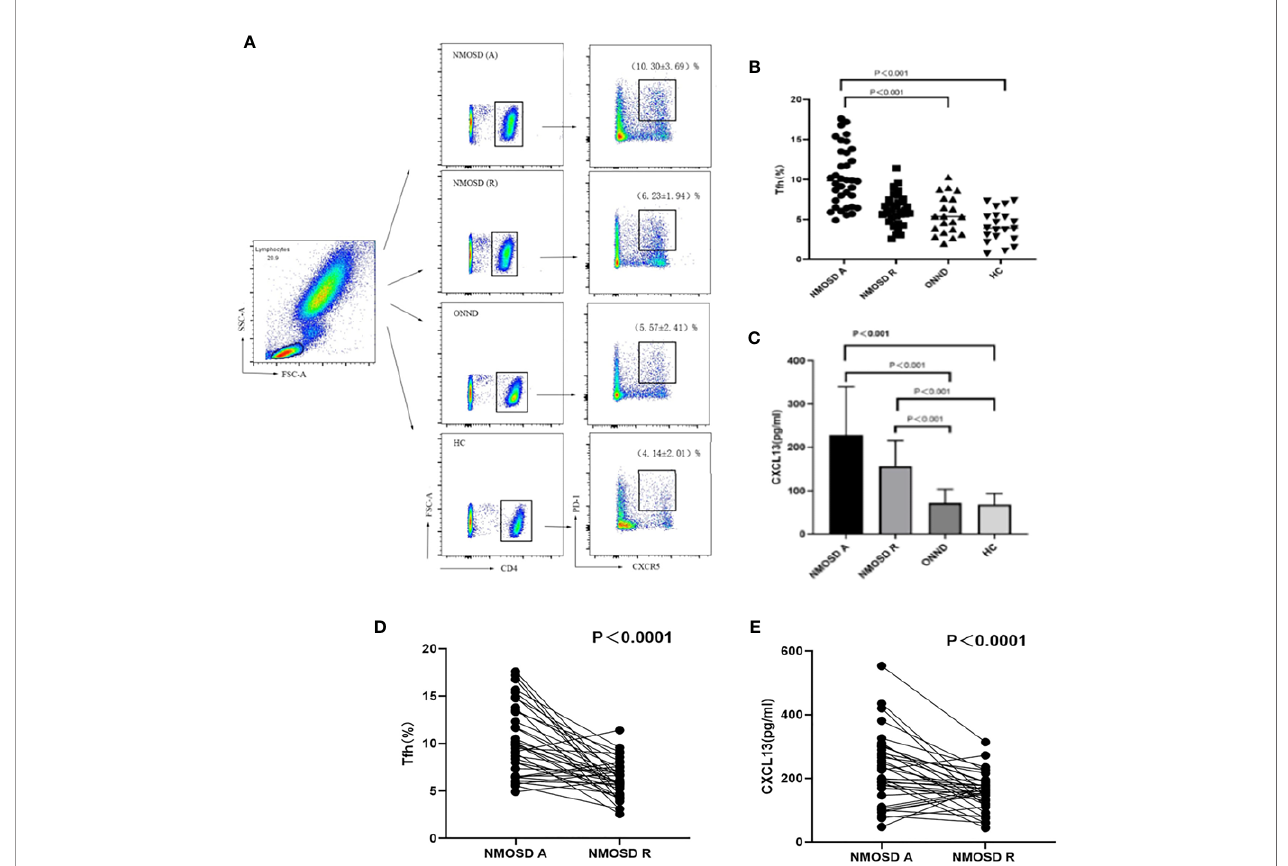
FIGURE 1 | FACS analysis of circulating Tfh cells in individual participants. The cells were gated to obtain results for lymphocytes, CD4+, CXCR5+ and PD-1+cells. (A) Flow cytometric analysis (B, C) Circulating Tfh cell ratio and serum CXCL13 levels in the acute and recovery stage of NMOSD, ONND and HC groups. (D) Comparison of circulation Tfh cell ratio in NMOSD. (E) Comparison of serum CXCL13 level in NMOSD. Each line represents the changes of Tfh and levels of CXCL13 in relapsing and remitting stage of NMOSD patients. NMOSD A, acute phase of NMOSD; NMOSD R, recovery phase of